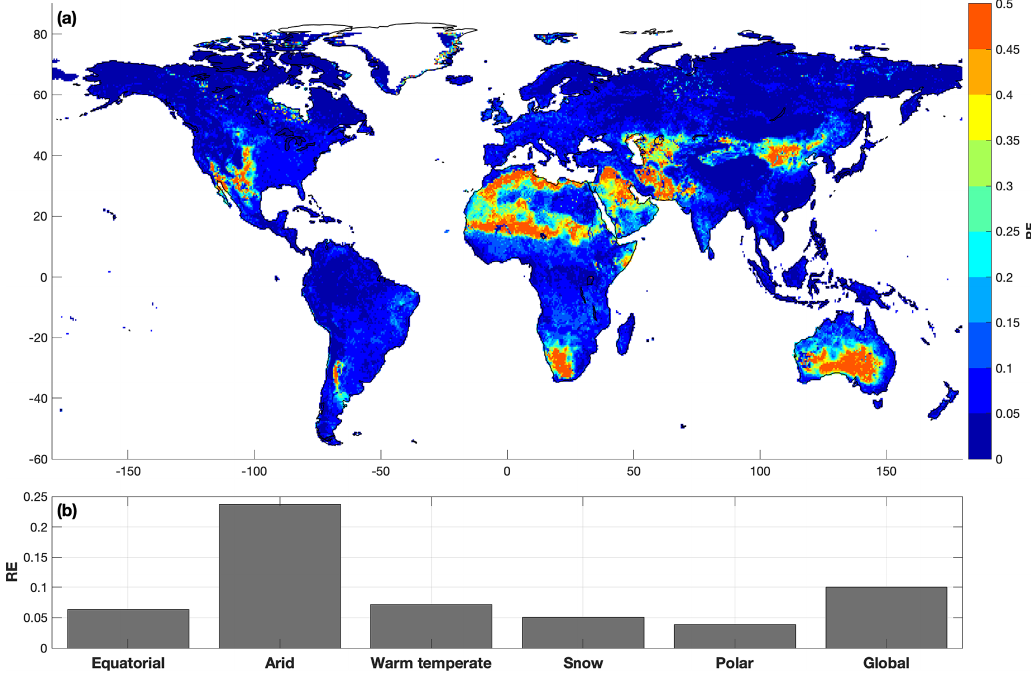
Figure 2. Relative norm 2 error of the surrogate models for the validation simulations. Panel (a) shows the spatial distribution of the errors, and panel (b) shows the average errors for the grid cells in each climate defined by Köppen climate classification.